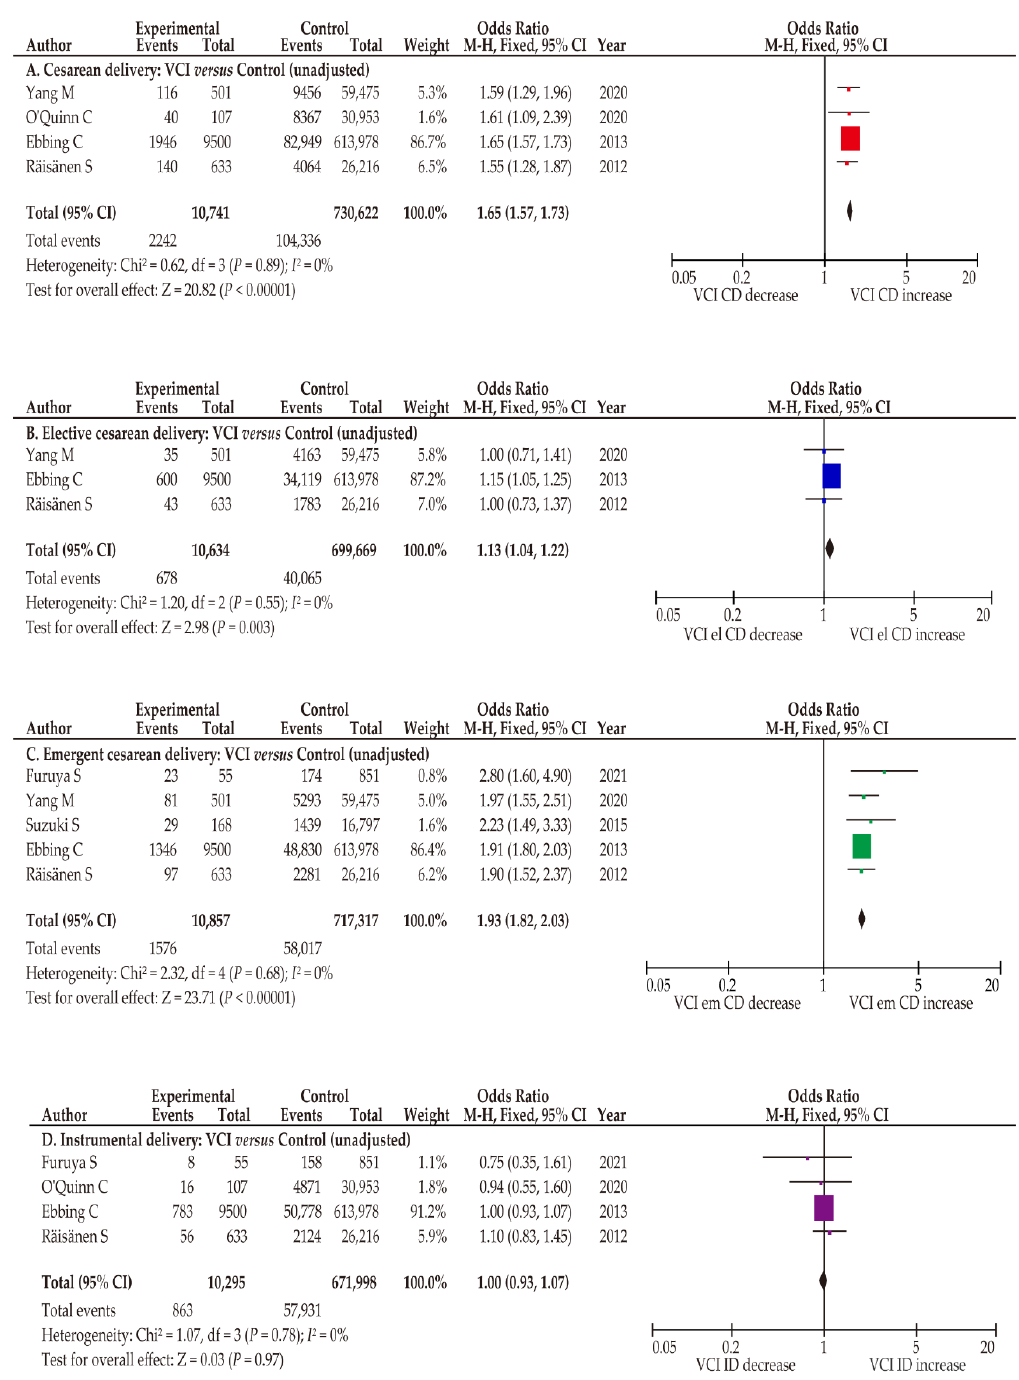
Figure 4. Effect of VCI on the rate of CD. Pooled odds ratios (ORs) were calculated using RevMan version 5.4.1 (Cochrane Collaboration, Copenhagen, Denmark). Thus, some values may be slightly different from their original state. The effect of VCI on the rate of CD was examined. No heteroge- neity was observed during the unadjusted analysis ( A – D , I 2 = 0%), and fixed-effect analyses were performed. ( A ) Comparison of CD rates between women with and without VCI, ( B ) comparison of elective CD rates between women with and without VCI, ( C ) comparison of emergent CD rates between women with and without VCI, and ( D ) comparison of instrumental delivery rates between women with and without VCI. Abbreviations: VCI, velamentous cord insertion; ART, assisted re- productive technology; CD, cesarean delivery; el CD, elective cesarean delivery; em CD, emergent cesarean delivery; OR, odds ratio; CI, confidence interval; SE, standard error.